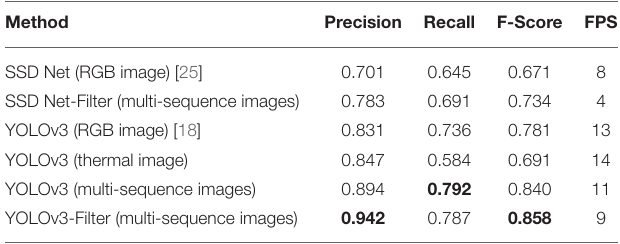
TABLE 1 | Performance of